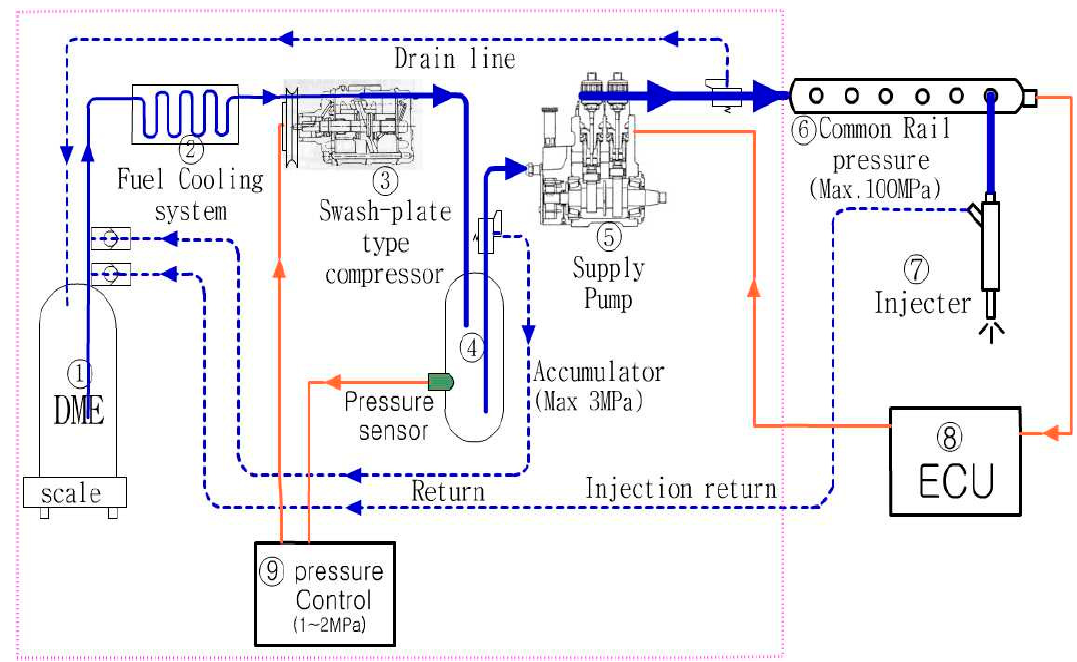
Figure 1. Schematic diagram of the liquid fuel supply system.